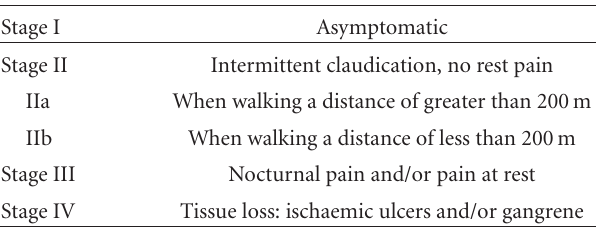
Table 1: Fontaine Classification: stages III and IV are also known as